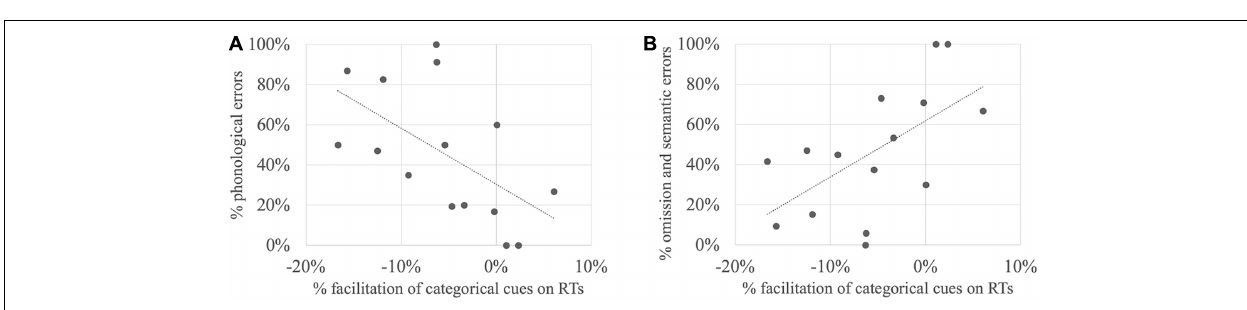
FIGURE 3 | Relationship between the amount of semantic facilitation with categorical cues (each dot represents a subject around the regression line) and the amount of (A) phonological errors; (B) omission and semantic